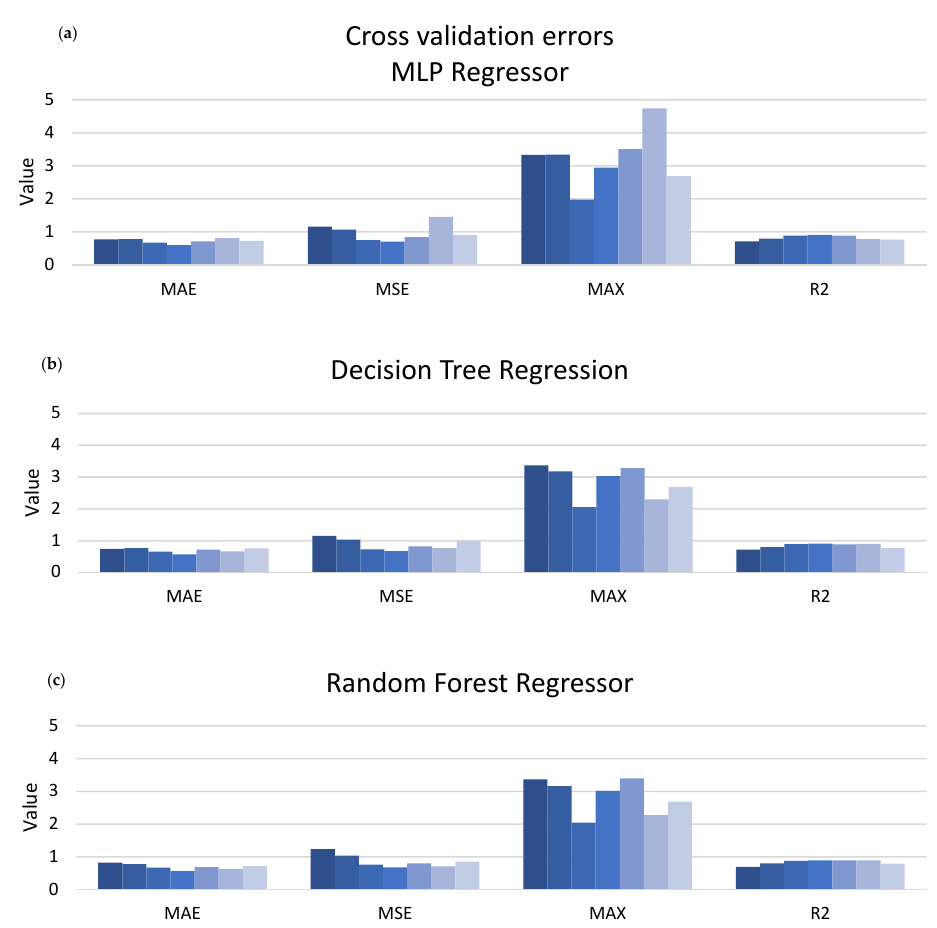
Figure 4. Performance measures’ values of the three remaining models on the last dataset. ( a ) for MLP regressor, ( b ) for DTR, ( c ) for RFR.